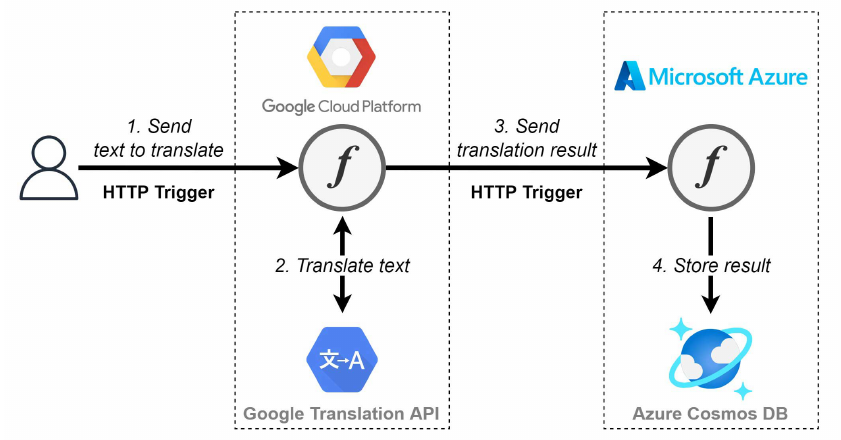
Figure 6. Use case 2— store translation